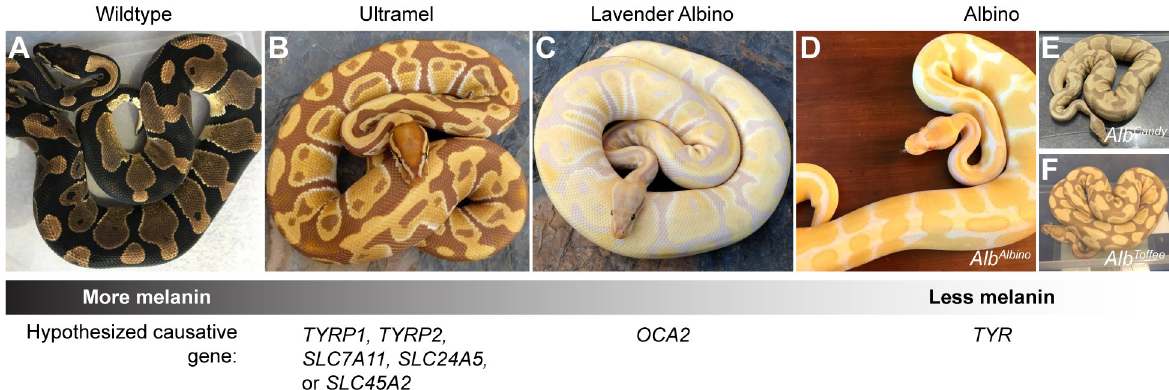
Fig 1. The Albino, Lavender Albino, and Ultramel color morphs have reduced brown-to-black coloration, characteristic of a loss of melanin. Red-to-yellow coloration is unaffected in these morphs. Hypothesized causative genes represent genes in which loss-of-function variants in other vertebrates produce similar phenotypes (Table 1). (A) Wildtype. (B) Ultramel. (C) Lavender Albino. (D-F) Albino. Phenotypes within the Albino color morph are variable, with some animals having skin patches that are white and others having skin patches that are light beige. (D) Albino animal described as an Alb Albino homozygote. (E) Albino animal described as an Alb Candy homozygote. (F) Albino animal described as an Alb Toffee homozygote. Photo credits, Ryan Young of Molecular Reptile, Chiron Graves, Phil Barclay, Michael Freedman of The Florida Reptile